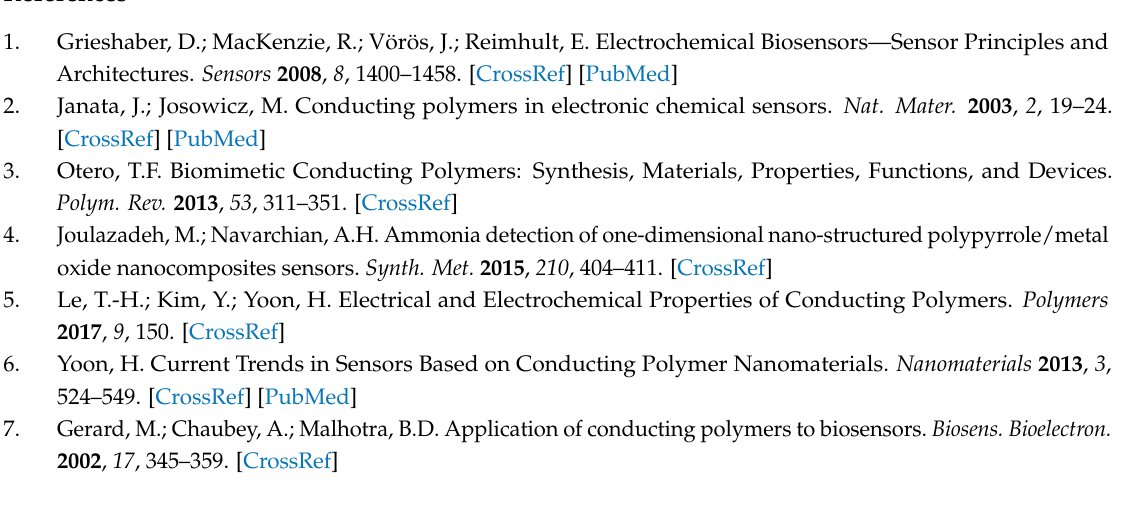
s1, Figure S1: Linear Sweep Voltammogram showing the oxidation of 3 mM DA on a Pt electrode covered with the aniline-piperazine copolymer. DA oxidation peak is centered at 0.85 V, Figure S2: Linear Sweep Voltammogram showing the oxidation of 30 mM AA on a Pt electrode covered with the aniline-piperazine copolymer. AA oxidation peak is centered at 0.89 V, Table S1: Observed frequencies and proposed assignments for the vibrational bands derived from Figures 2 and